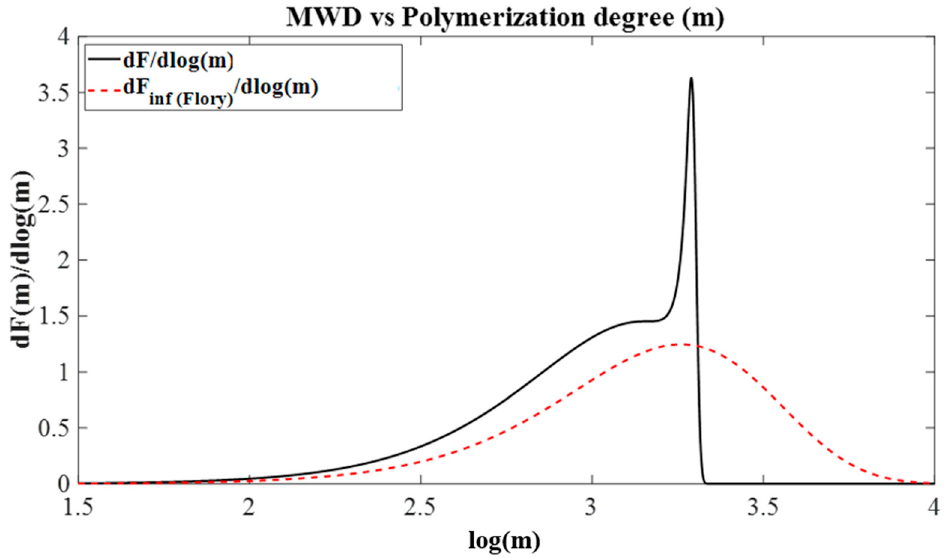
Figure 2. Molecular weight distribution according to Equations (33) and (34) ( K P = 100/s, K I = 1/s, K T = 0.1/s, K D = 0.01/s, t = 20 s).